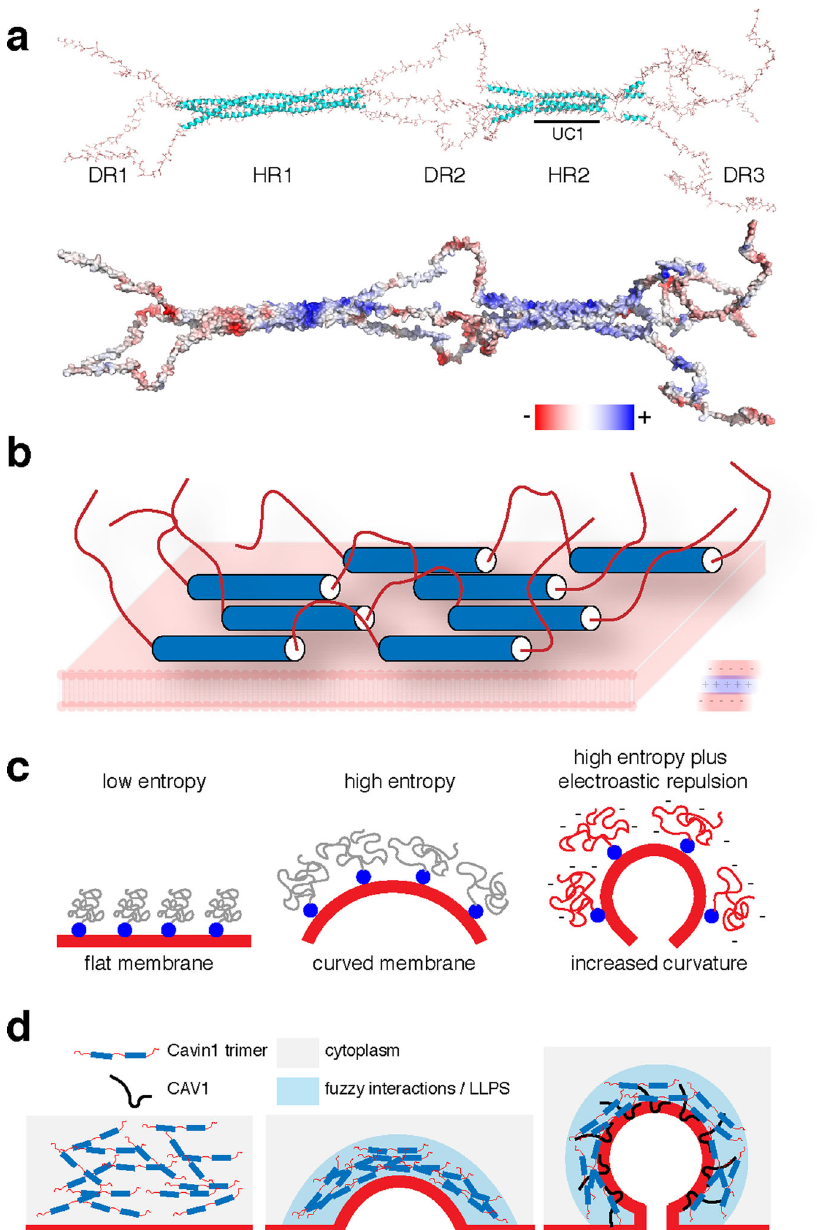
Fig. 9 Model for the role of Cavin1 DR domains in LLPS and caveola formation. a Structural model of a Cavin1 homotrimeric assembly. The trimeric HR1 coiled-coil domain is derived from the crystal structure of the mouse Cavin1 HR1 domain 11 , the UC1 and HR2 domains are modelled as described previously 10 , and the DR domains are modelled as random coil structures (see “ Methods ” section for further details). The structure is shown in ribbon diagram (top) and with an electrostatic surface representation (bottom). b Proposed orientation of Cavin1 proteins on the membrane surface, with membrane-binding HR1 and HR2 domains associated with the phospholipid bilayer and negatively charged DR sequences directed outwards due to electrostatic repulsion. c Potential role of Cavin1 disordered sequences in membrane curvature generation due to steric crowding. This concept is largely derived from previous studies of other membrane-associated proteins 73,74 . d Potential role of Cavin1 fuzzy interactions and LLPS in membrane curvature generation, CAV1 interaction and caveola